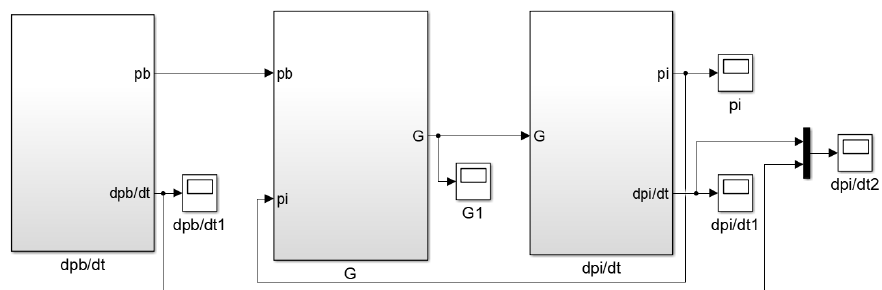
Figure 5. Simulation model of the brake pressure change rate ignoring temperature change.